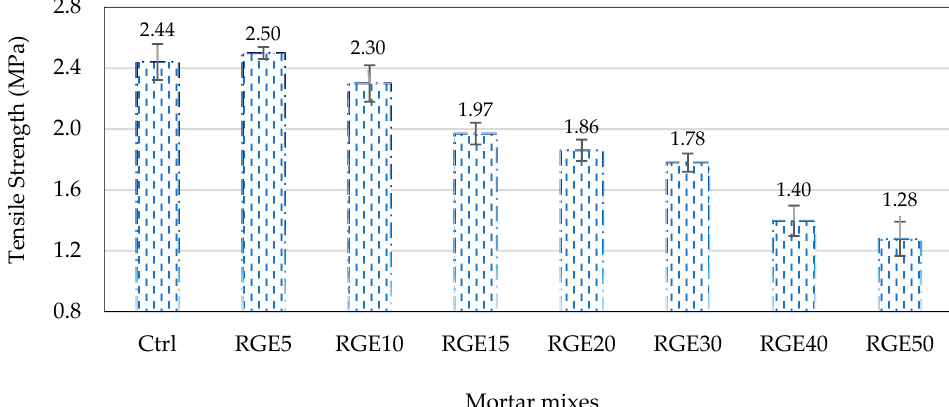
Figure 8. Splitting tensile strength of specimens at 120 days.